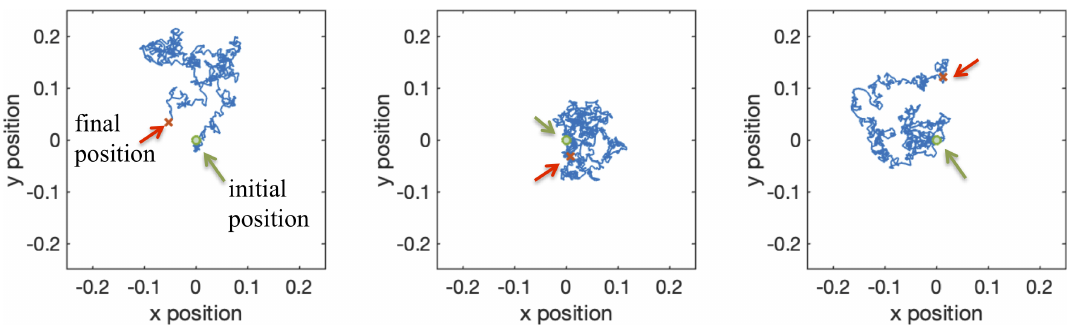
Figure 2. Evolution of 2D particle position for three different solutions of Equation (1). All three trajectories start from an initial position ( 0,0 ) . In all three figures, ∆ t = 0.001 and the simulation ran for 1000 time